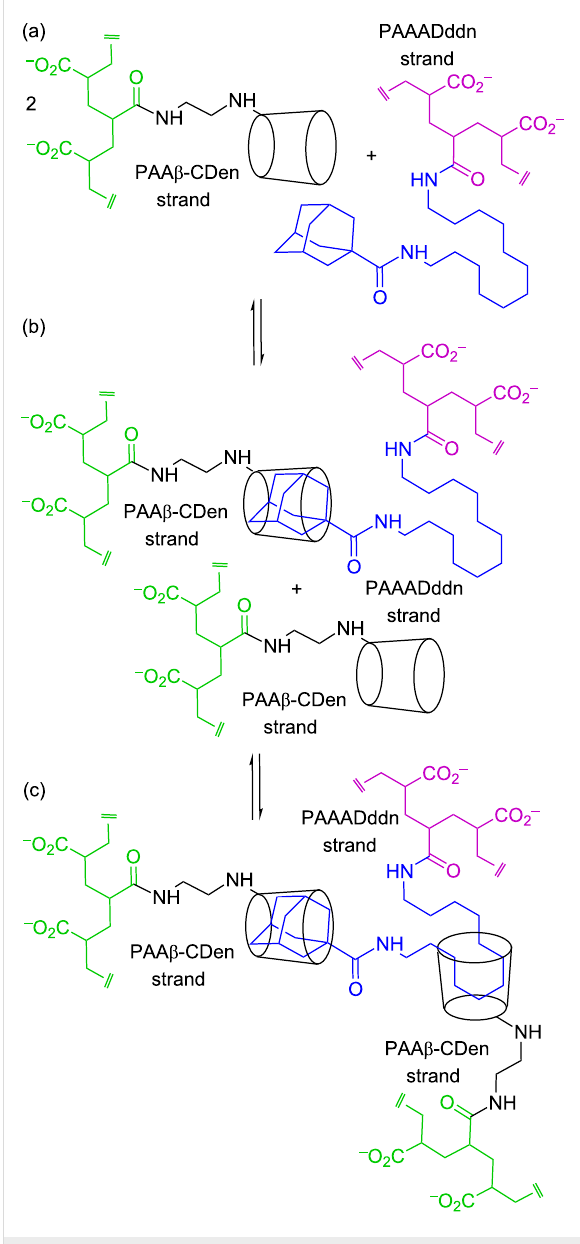
Figure 4: Representation of ditopic complexation of an ADddn substit- uent of PAAADddn, by two β -CDen substituents of PAA β -CDen through initial complexation of the adamantyl group followed by com- plexation of the dodecyl linker in the sequence (a) to (b) to (c).